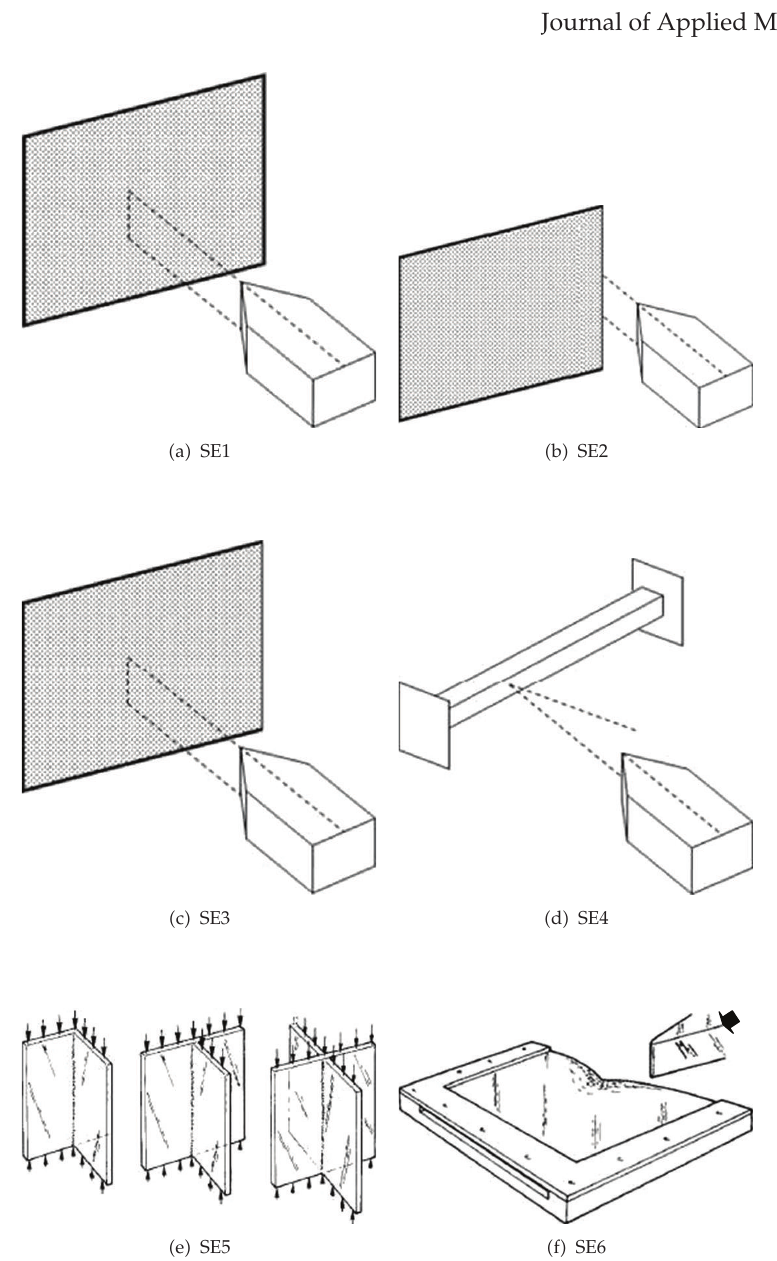
Figure 5: Description of superelements for oblique collisions— (cid:3) e (cid:4) and (cid:3) f (cid:4) are extracted from (cid:5) 6 (cid:6)